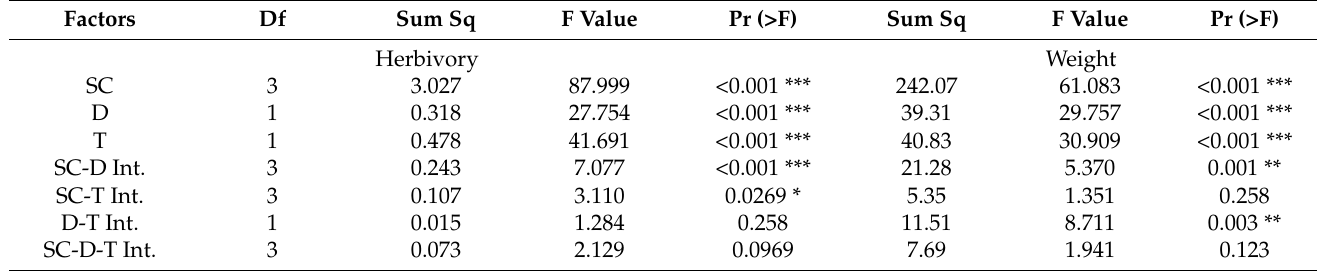
Table 3. Slug herbivory and slug weight in response to slug control (SC), time (T), and design (D) or their interactions (Int.). Df = degrees of freedom, Sum Sq = sum of squares, Pr (>F) = p value.